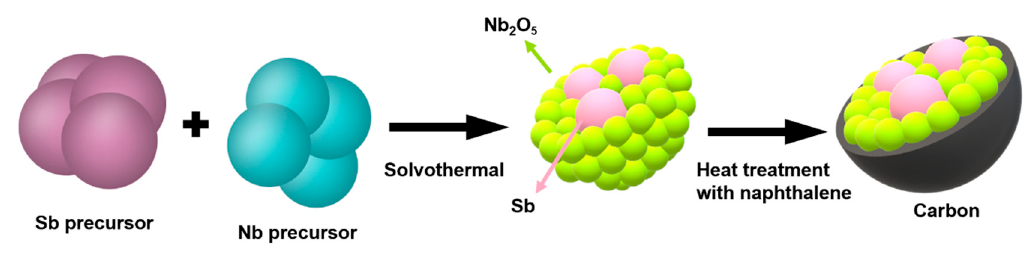
Figure 1. Schematic illustration of the synthesis of the spherical Sb core/Nb 2 O 5 -C double-shell.